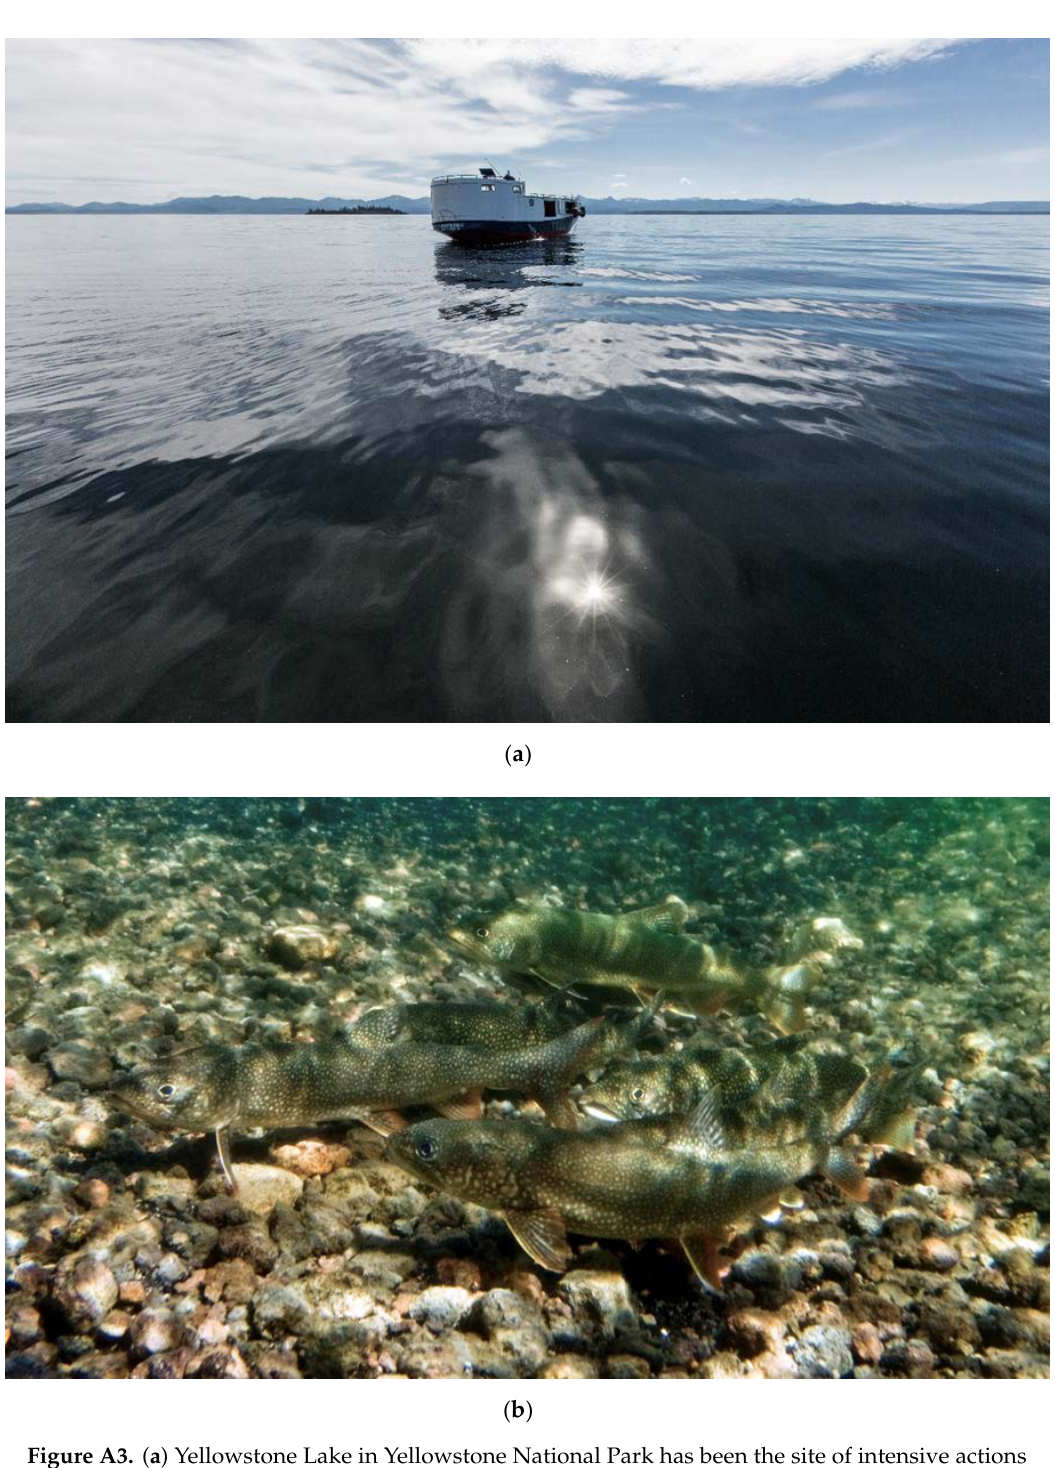
Figure A3. ( a ) Yellowstone Lake in Yellowstone National Park has been the site of intensive actions to suppress ( b ) invasive predatory lake trout [26] and restore native Yellowstone cutthroat trout and natural ecosystem function [24].